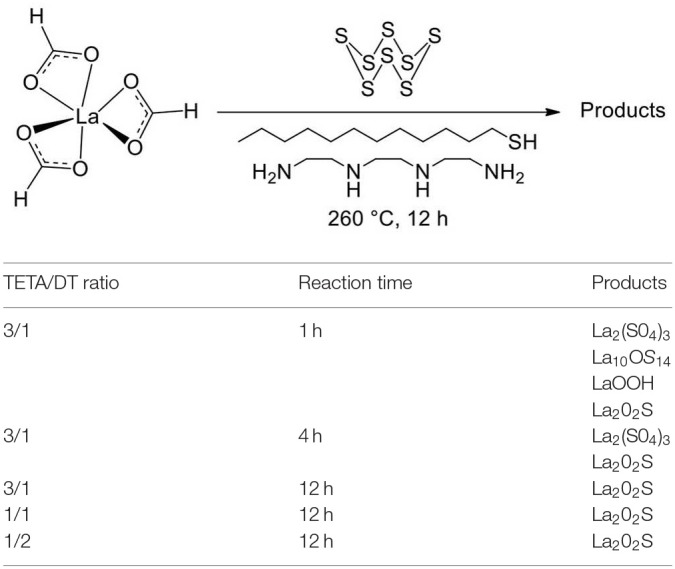
Reaction of Ma et al. (2013) to yield La2O2S nanoparticles.